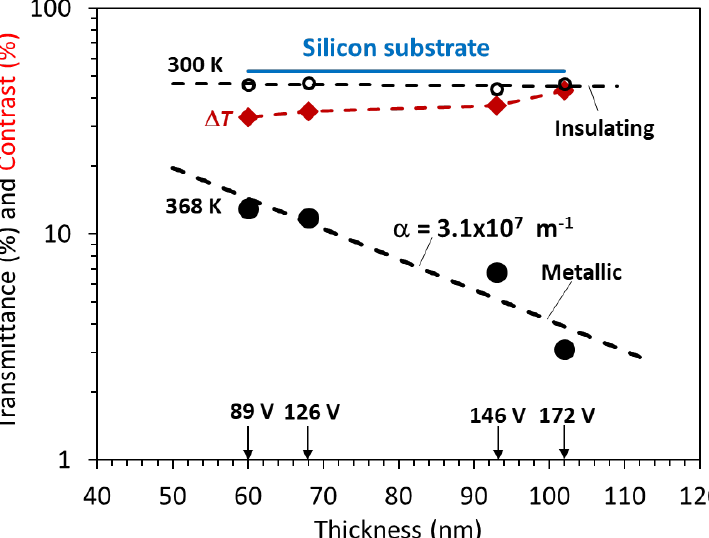
Figure 5. Optical transmittance of VO 2 thin films deposited under different bias voltage at ( a ) 300 K and ( b ) 368 K.